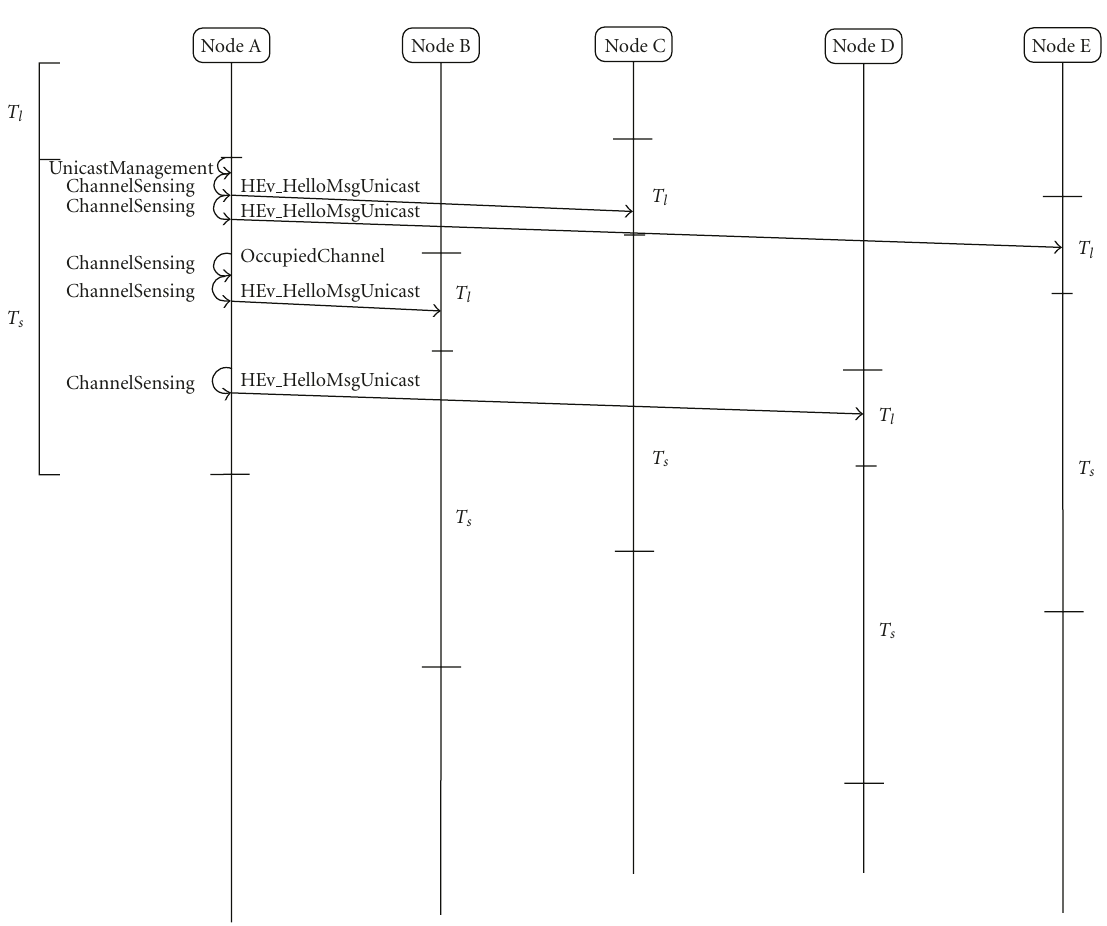
Figure 3: Message passing occurring within the regime phase of the proposed D-STAR